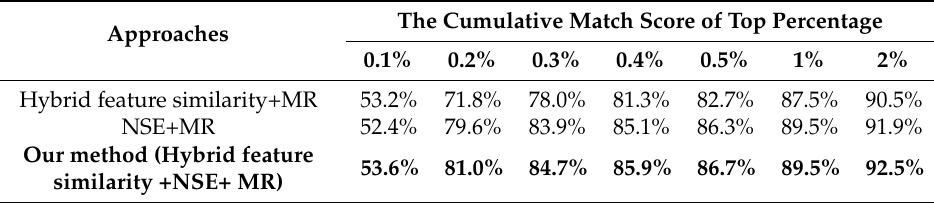
Table 6. Comparison with the traditional manifold ranking